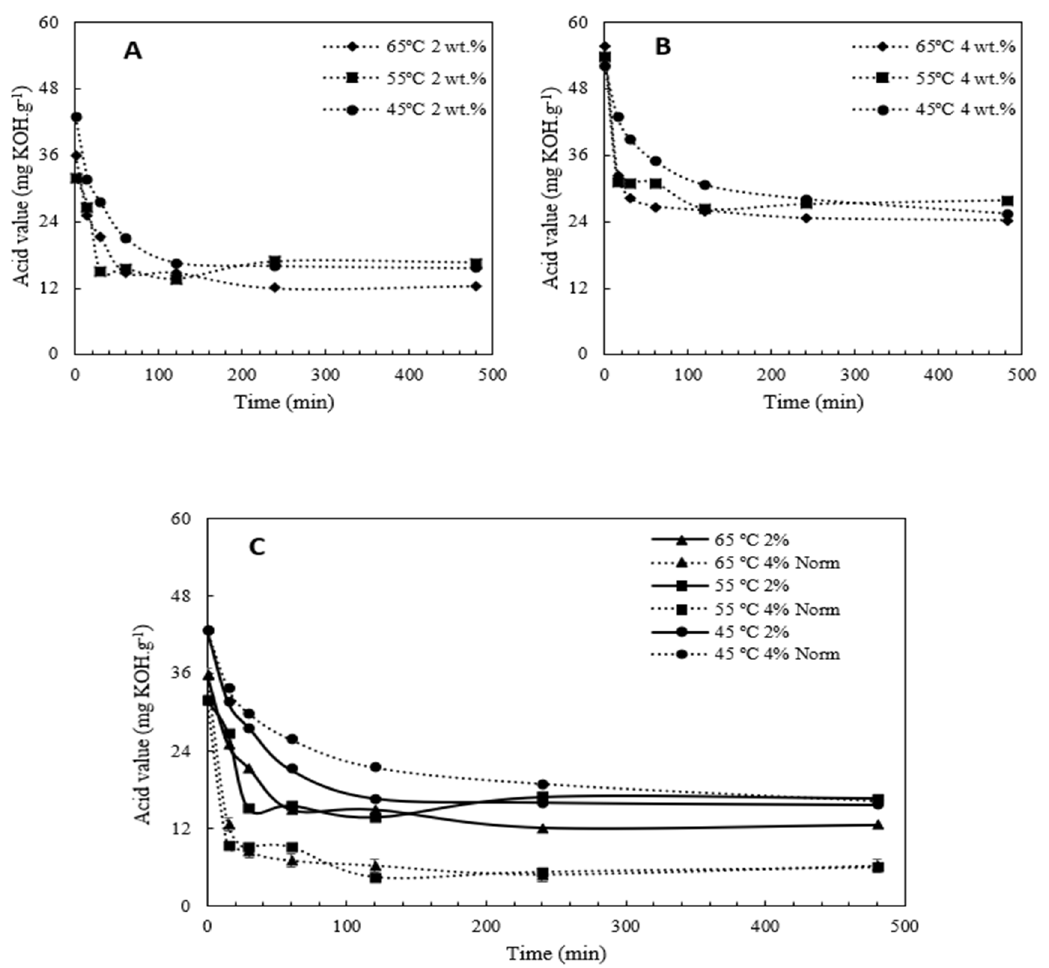
Figure 3. Evolution of the acidity during the homogenous acid esterification of the acid oil for a catalyst amount of 2 wt.% ( A ) and 4 wt.% ( B ) at different temperatures; results comparing the use of 2 wt.% catalyst and normalized values in the case of 4 wt.% ( C ).